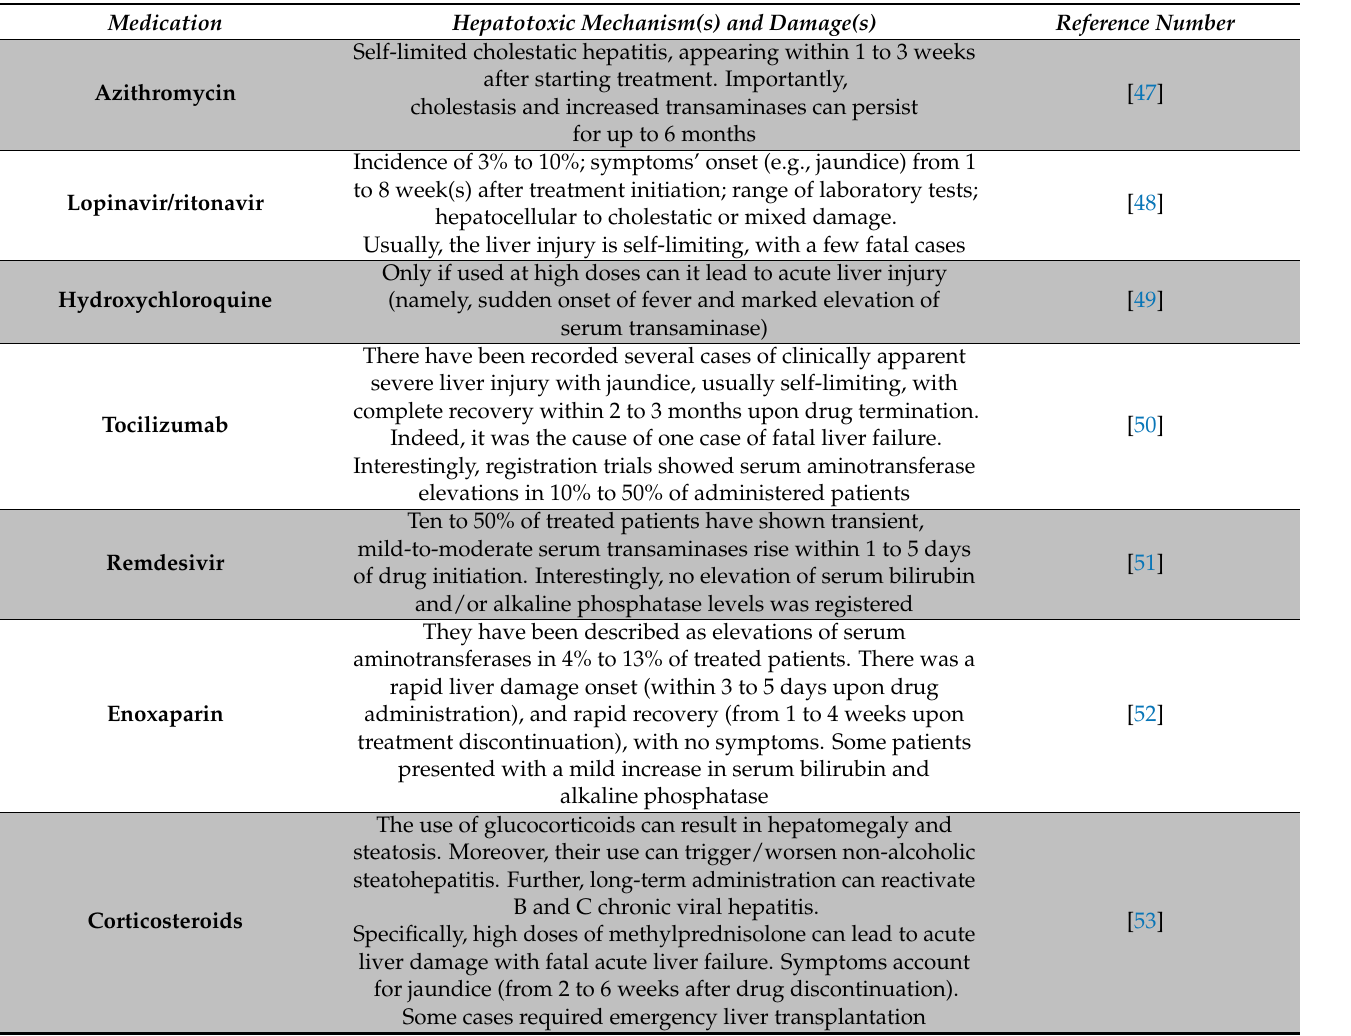
Table legend: First line is in bold and italics as it defines medications, hepatotoxic mechanisms and references reviewed; first column is in bold as distinguish medications to be reviewed. Indeed, the main drugs’ metabolism occurs in the liver, with a constant risk for COVID-19 patients, often treated with multi-medications or step-wise